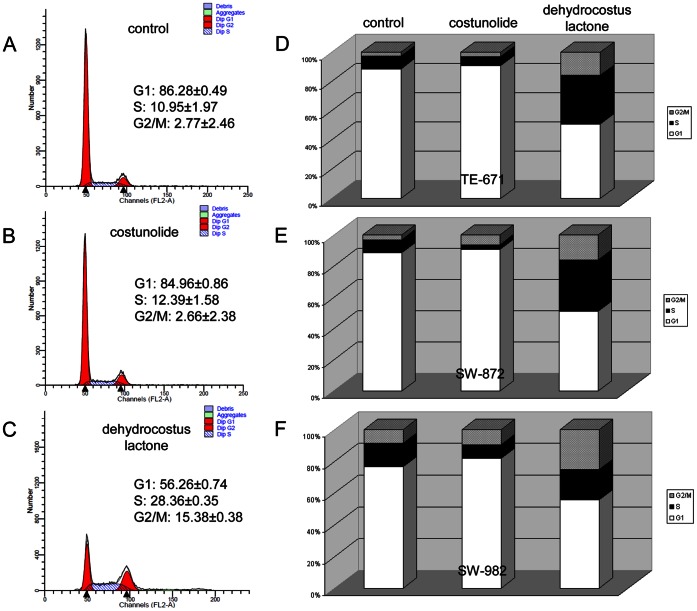
Influence of sesquiterpene lactones on cell cycle distribution.A) Untreated TE-671 cells were measured as control. B) Treatment of TE-671 cells with the IC50 of costunolide led to a very small change in the distribution, whereas, C) the IC50 of dehydrocostus lactone caused a significant decrease in the number of cells in G1 phase after 48 h which was accompanied by an increase of the number of S and G2/M phase cells. Values are expressed as percentage of the cell population in the G1, S, and G2/M phase of cell cycle. Graphical representations of the cell cycle distribution of D) TE-671, E) SW-872, and F) SW-982 cells.